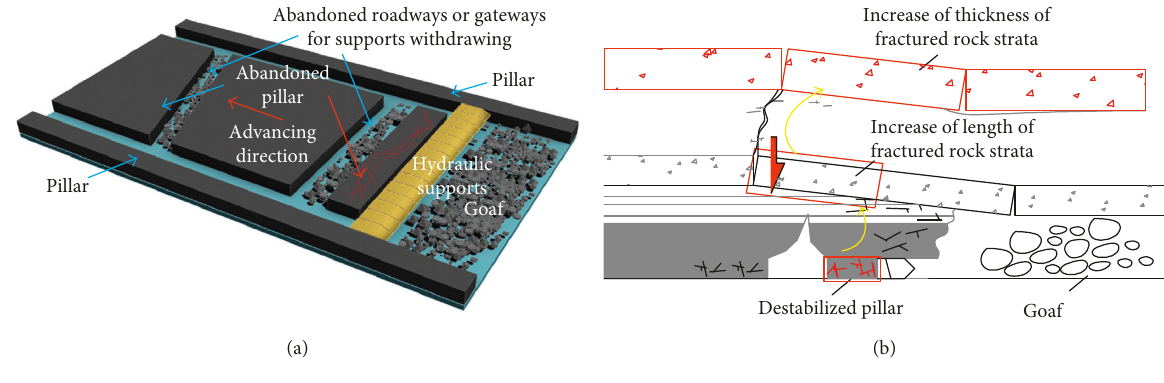
Figure 1: Diagram of abnormal fracture of overlying